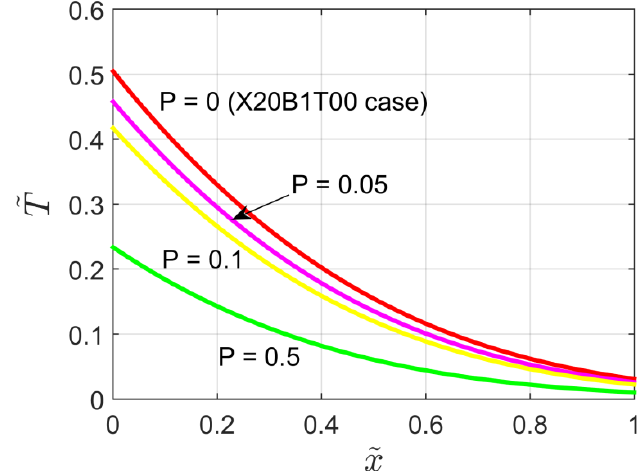
Figure 6. Dimensionless temperature distribution for the X40B1T00 problem for different values of the heat capacity ratio.